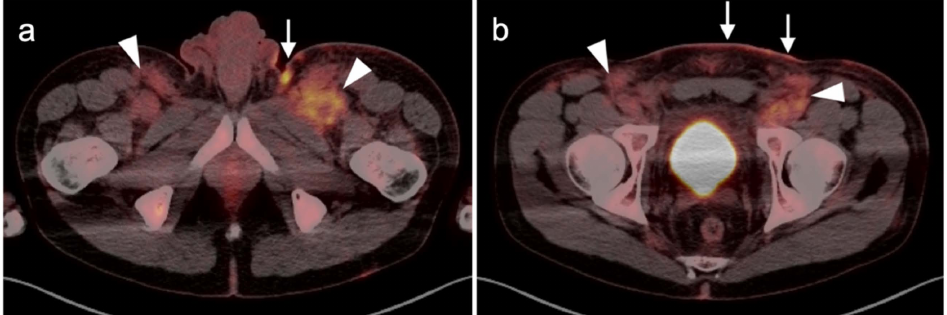
Figure 19. HIV-associated Kaposi sarcoma. ( a , b ) Axial FDG PET-CT images of the pelvis demonstrate hypermetabolic cutaneous plaques and nodules (white arrows) and ill-defined hypermetabolic lymph nodes (white